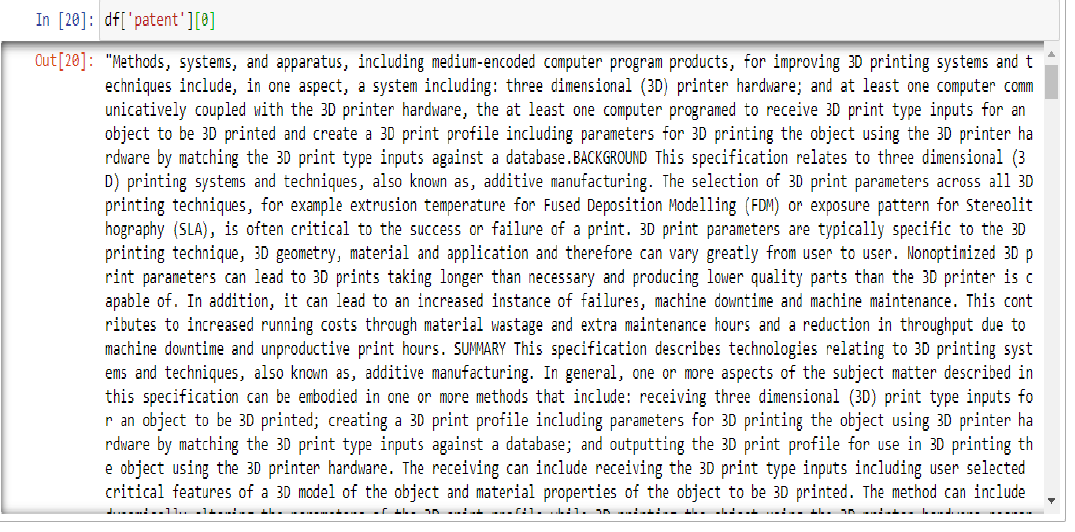
Figure 3. Patent text.